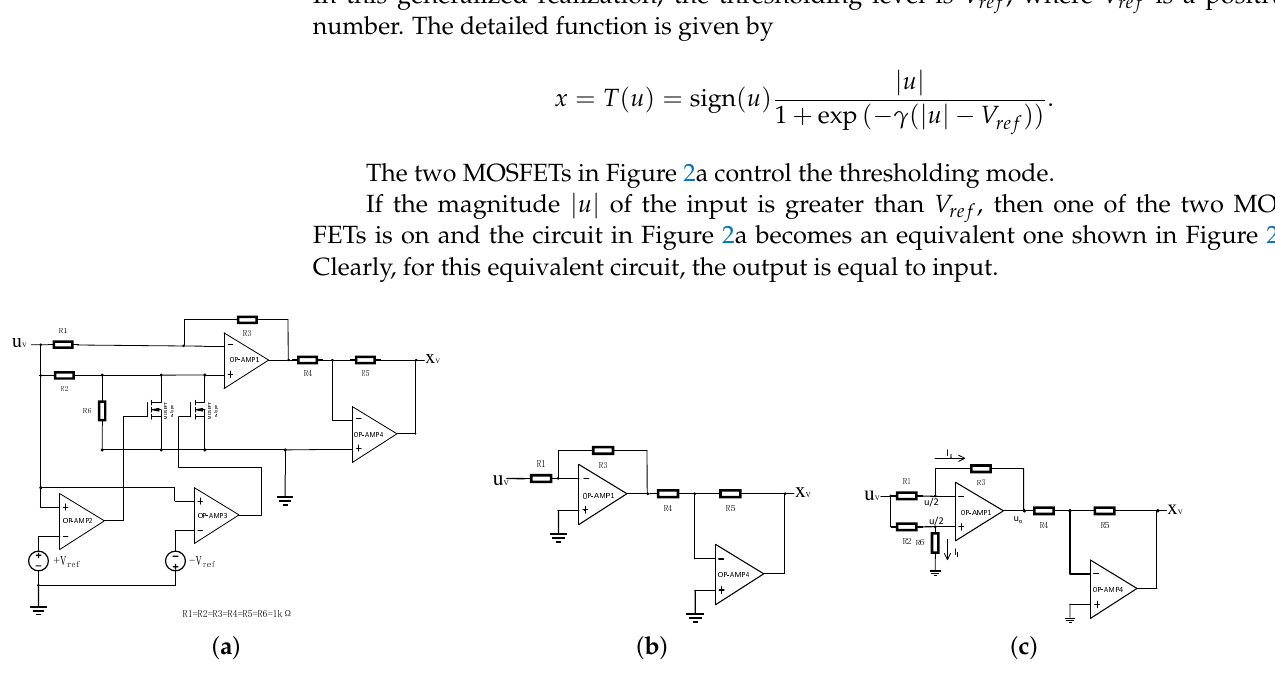
Figure 2. ( a ) Circuit for the thresholding function T ( x ) . ( b ) Equivalent circuit of the thresholding func- tion T ( x ) when the magnitude of input is greater than V ref . ( c ) Equivalent circuit of the thresholding function T ( x ) when the magnitude of input is less than or equal to V ref